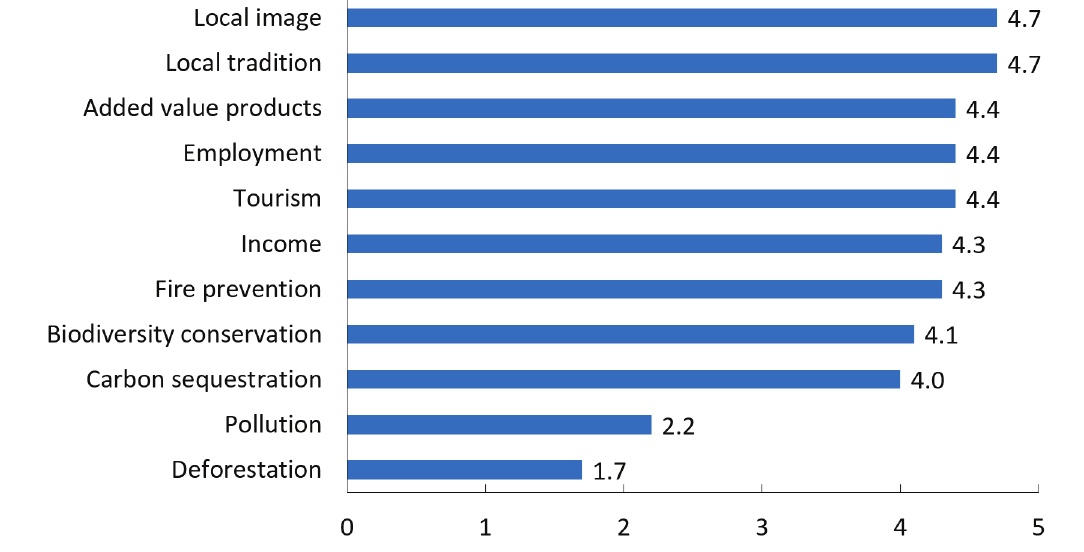
Figure 3. Pastoral ES